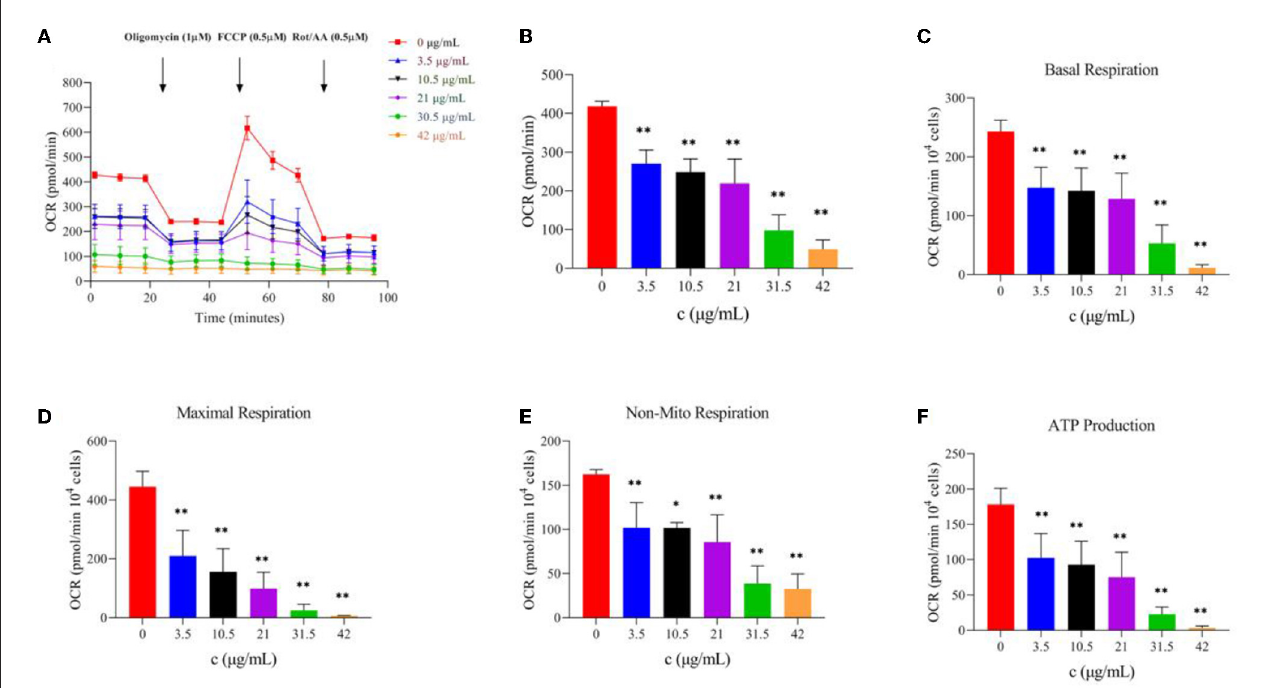
FIGURE5 Effect of TG on oxidative phosphorylation of HepG2 cells. (A) OCR value curve at different time intervals. (B) OCR bar chart of TG with different concentrations. (C) Basic respiration at different TG concentrations. (D) Maximum respiration at different concentrations. (E) Non-mito respiration at different TG concentrations. (F) ATP production at different TG concentrations. * P < 0.05 and ** P < 0.01.